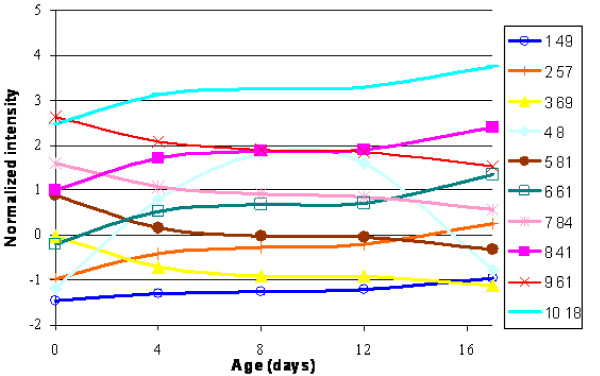
Expected cDNA expression trajectories for each of the 10 groups identified in the mellifera (M) data set. The legend indicates the group number and the estimated number of cDNAs per group.